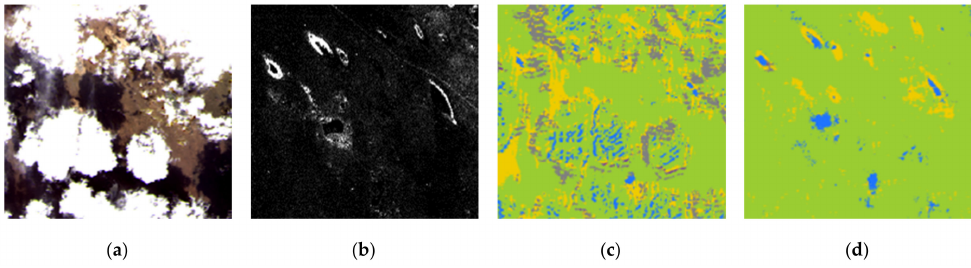
Figure 14. Different classification results using different data sources in an example cloud-covered area. ( a ) Source MS image; ( b ) source SAR image; ( c ) results without using SAR data; ( d ) results using SAR data.